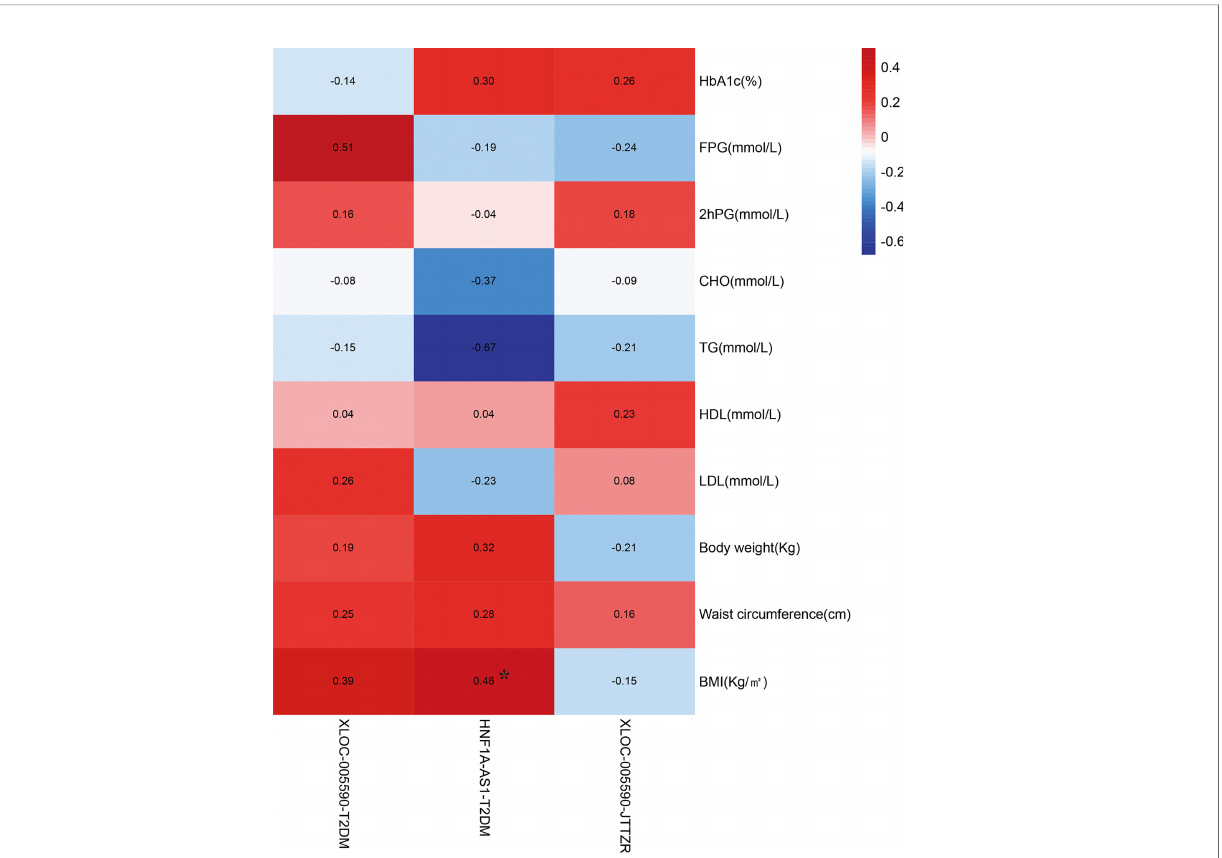
FIGURE 15 | Correlation analysis between changes in clinical indicators and target lncRNA in the qPCR results. *P < 0.05.